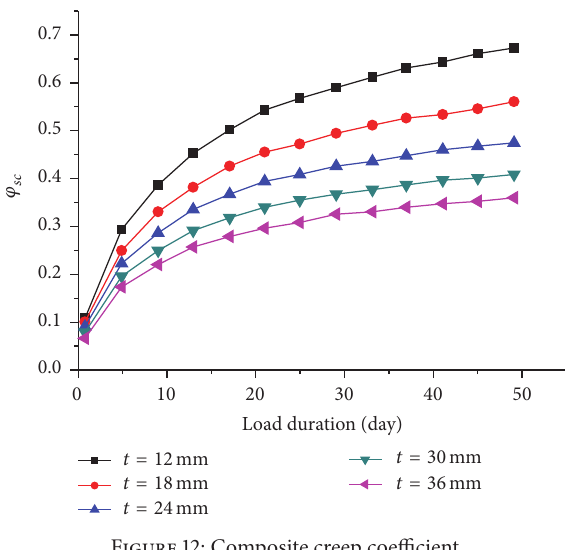
Figure 12: Composite creep coefficient.